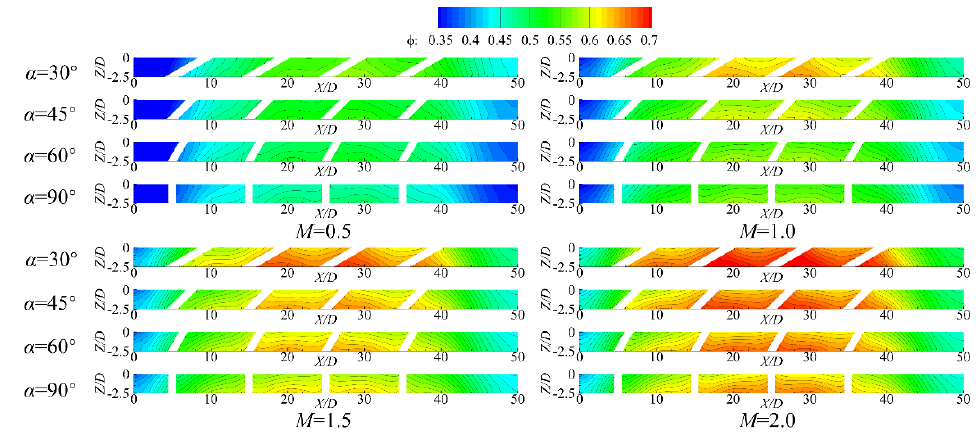
Figure 11. Contours of non-dimensional temperature at Y = 0 plane for solid domain for all cases.